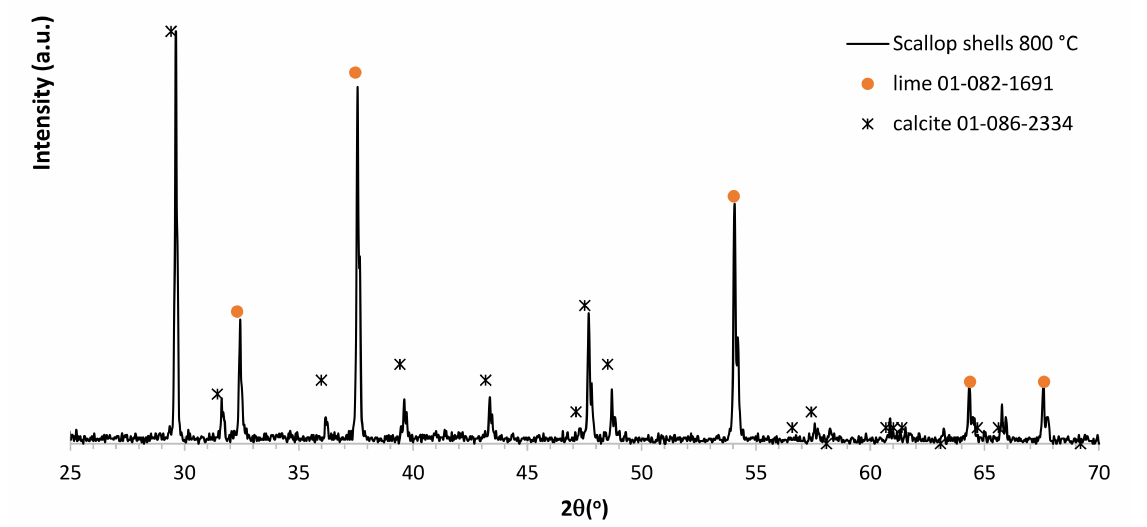
Figure 4. XRD pattern of fresh catalysts (scallop shell calcined at 800 ◦ C) and JCPDS standard files for calcite (CaCO 3 ) and lime